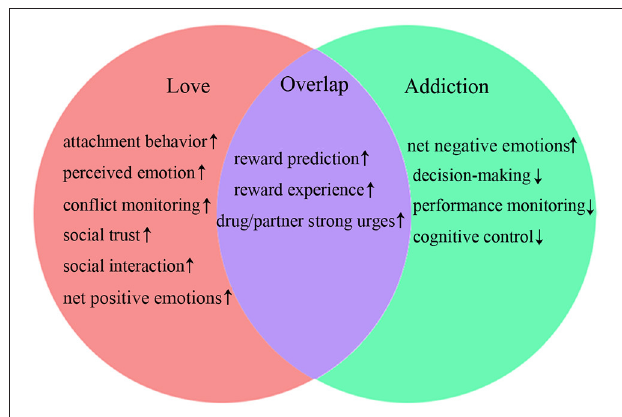
FIGURE 2 | Comparison of cognitive functions. ↑ , function increases; ↓ , function